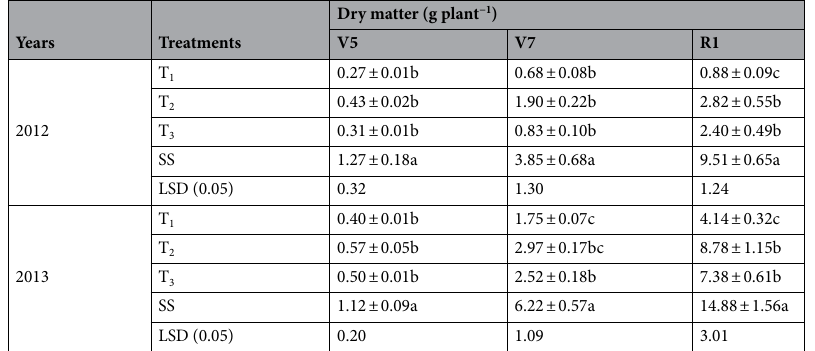
Table 3. Effect of different strip-width treatments on dry matter of soybean at fifth trifoliate stage (V5), seventh trifoliate stage (V7), and flower initiation stage (R1) in cropping seasons from 2012 to 2013. Treatment codes represent narrow-strips (T 1 , 180 cm); medium-strips (T 2 , 200 cm); and wide-strips (T 3 , 220 cm) in maize/soybean relay intercropping system. SS is the sole cropping system of soybean. Means are averages over three replicates ± standard error of the mean. Means that do not share the same letters in a column differ significantly at p ≤ 0.05 using least significant differences, calculated separately for each year.